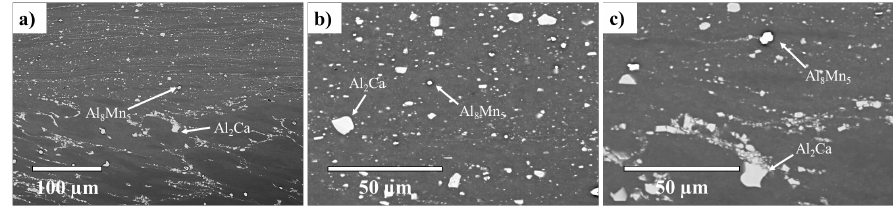
Figure 8. AZ91–2Ca/AZ91–2Ca weld. SEM micrographs of ( a ) the weld region between the base material (bottom) and the central weld zone (top), ( b ) the central weld zone, and ( c ) fragmentation of Al 2 Ca particles close to the central weld zone.